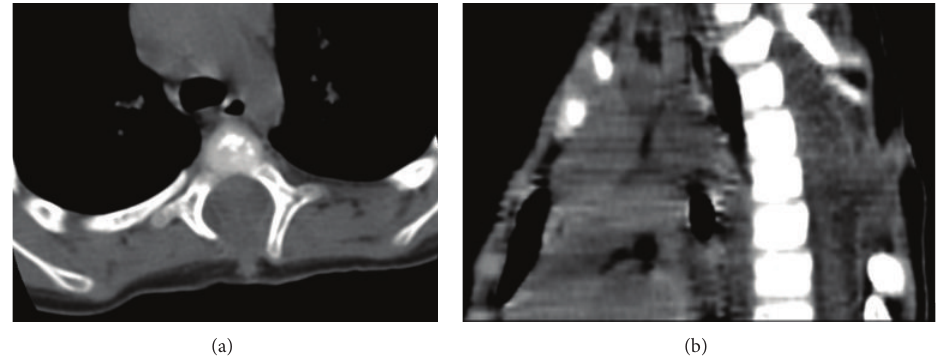
Figure 2: Axial (a) and sagittal (b) CT images. There is deficiency of the posterior elements at T3–T6, with remodeling and widening of the spinal canal. A soft tissue attenuation tract extends to the skin